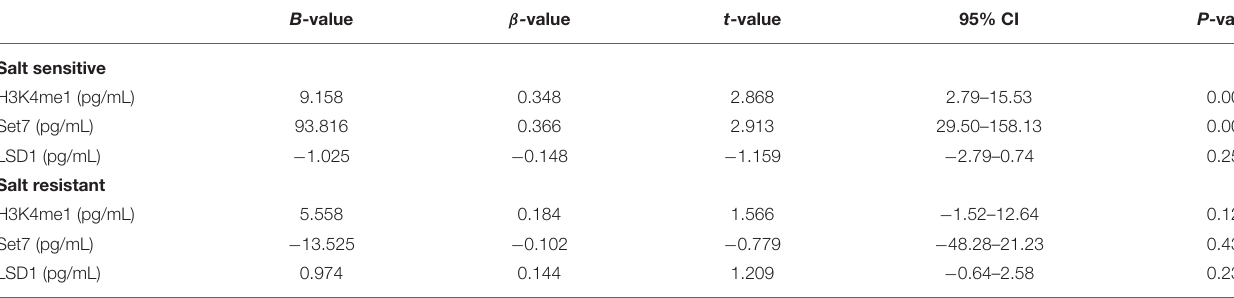
TABLE 3 | Associations of 24h salt intake with serum H3K4me1, Set7, and LSD1 according to salt